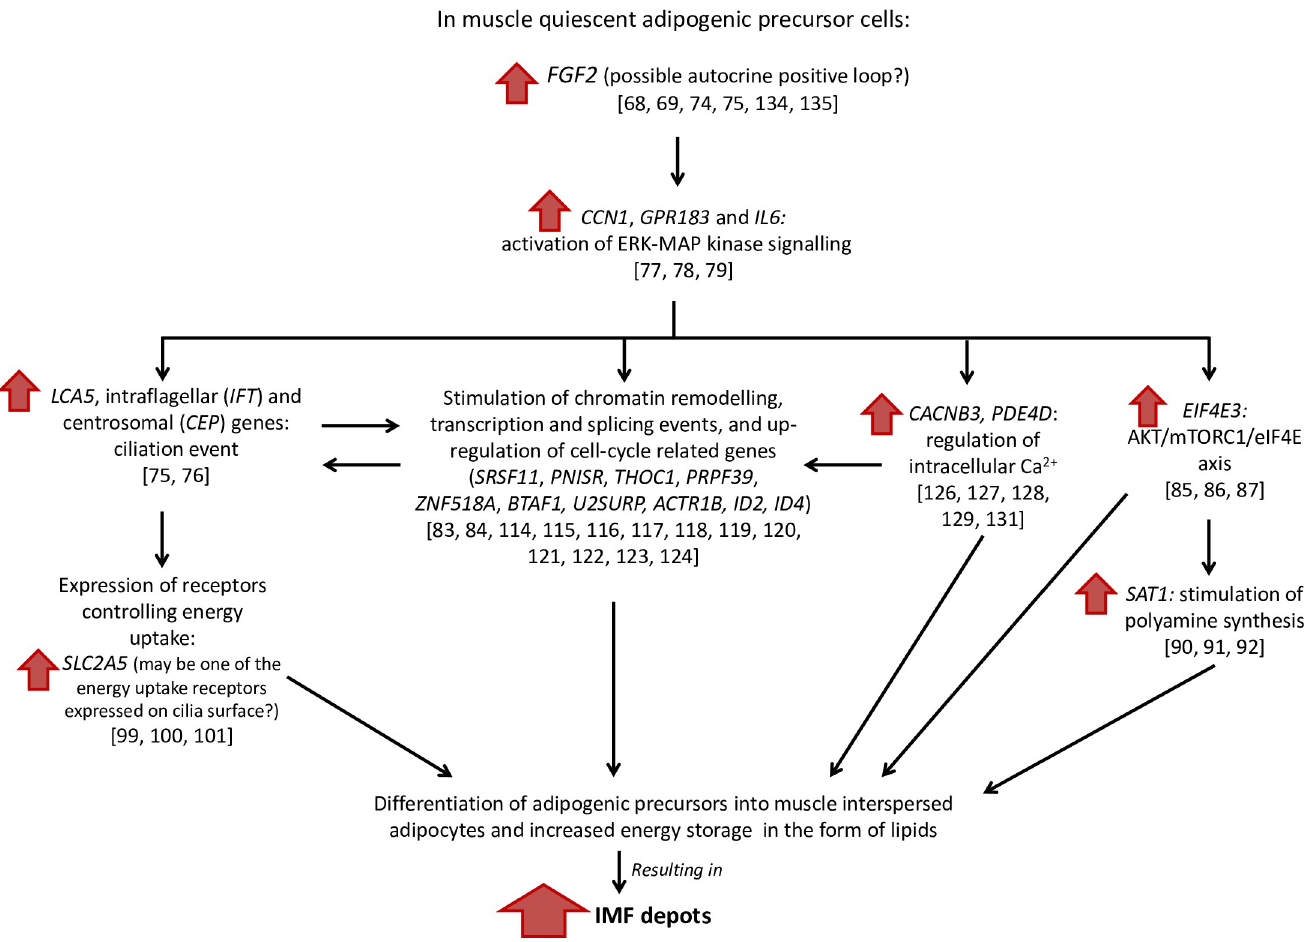
Fig 8. A hypothetical molecular cascade of events involved in Intramuscular fat (IMF) deposition based on the obtained results and comparison with the scientific literature. Between brackets are reported the references endorsing each step in the hypothetical cascade of molecular events.